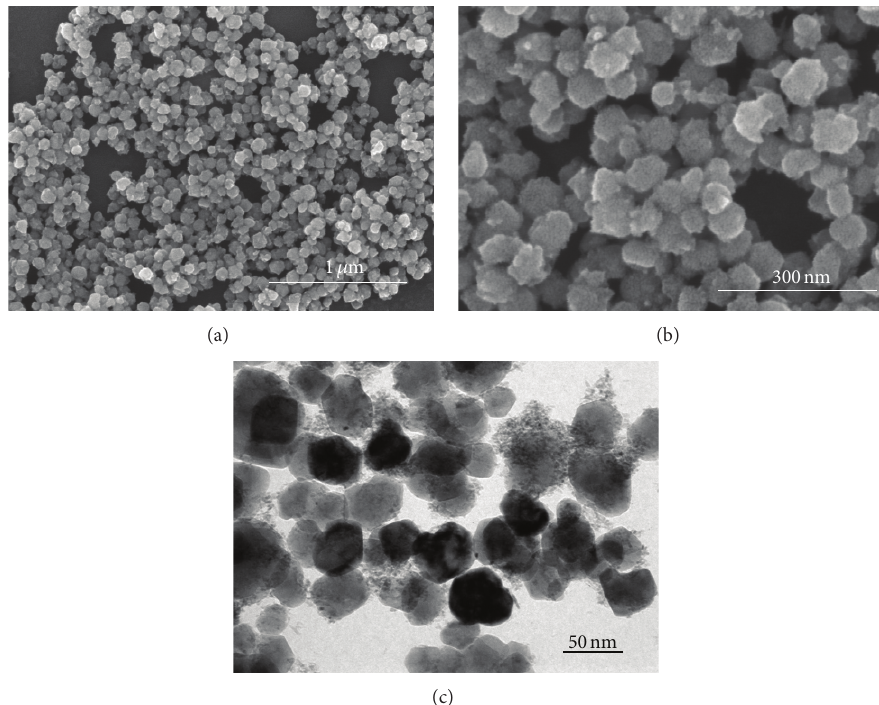
Figure 2: FESEM and TEM images of the Zn-doped SnO 2 /Zn 2 SnO 4 nanocomposites: (a) the panoramic FESEM image; (b) the high magnification FESEM image; and (c) TEM image.